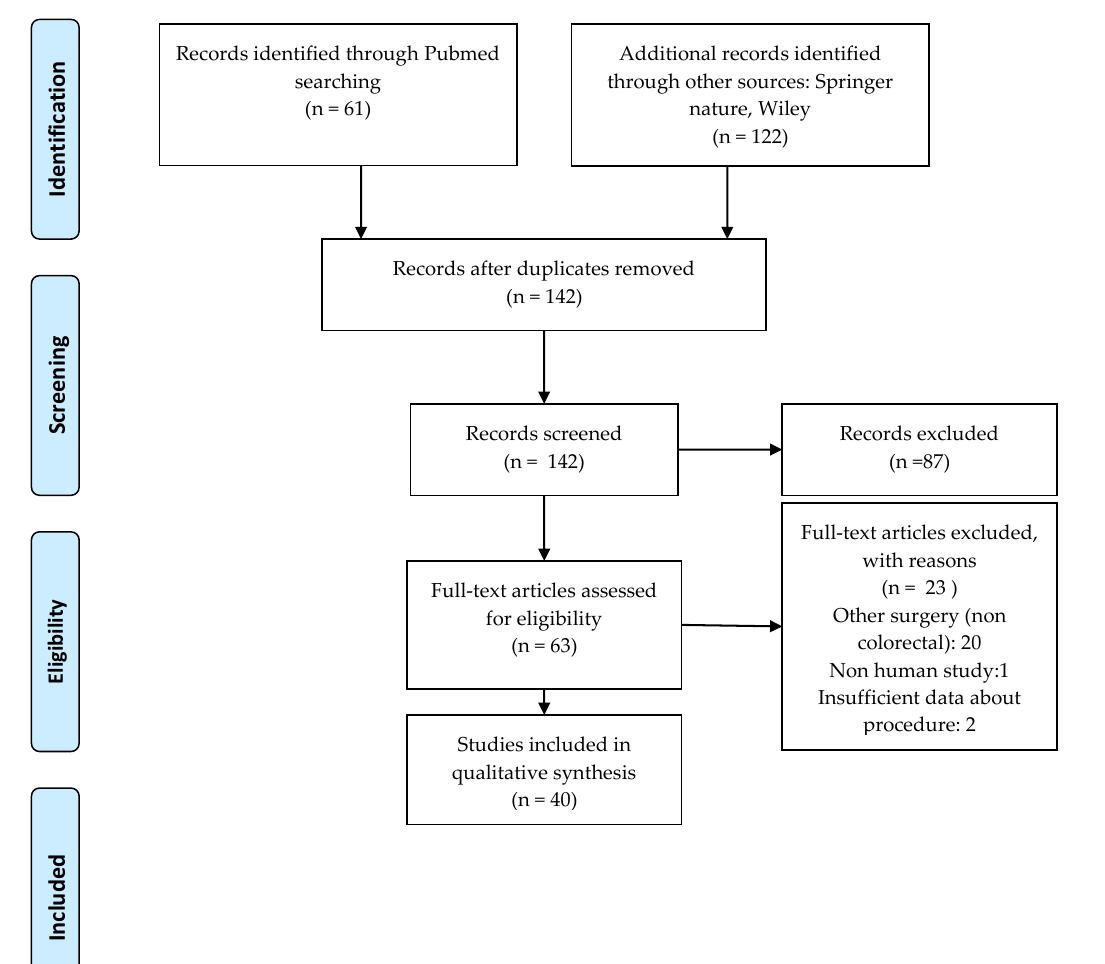
Figure 1. Preferred Reporting Items for Systematic Reviews and Meta-Analyses ( PRISMA) flow Figure1. diagram.